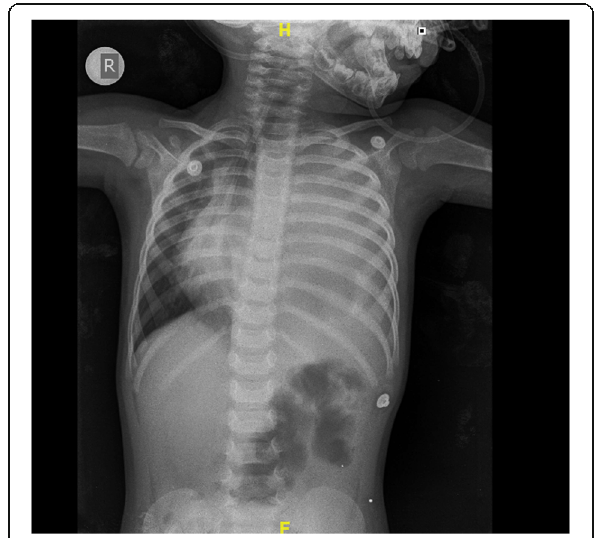
Fig. 1 Pre-operative chest x-ray showing shift of mediastinum to the right and whiteout of the left hemithorax